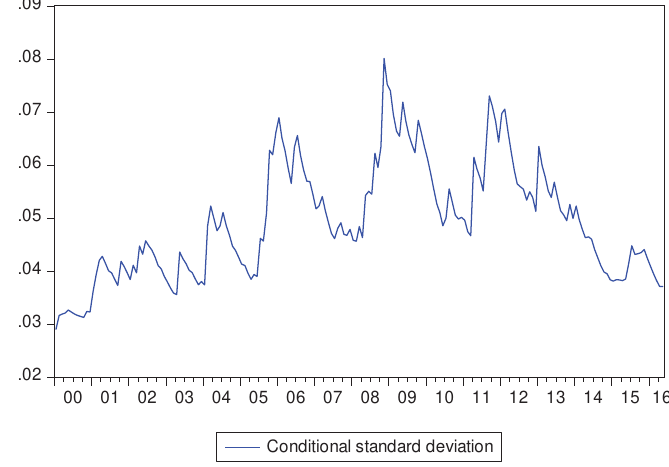
Fig. 1. Conditional volatility estimated from modeling